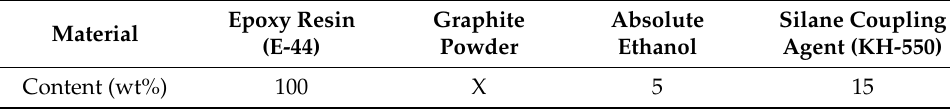
Table 1. Proportions of each conductive coating